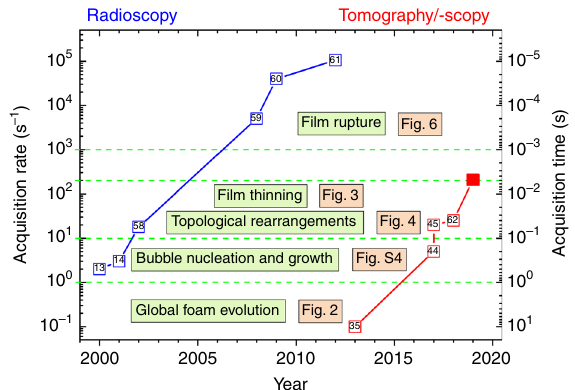
Fig. 1 Image acquisition rates and times used to study metal foams. The highest image acquisition rates in each year achieved for 2D radioscopic (blue, in s − 1 , fps) 13,14,58 – 61 and 3D tomoscopic (red, in s − 1 , tps) 35,44,45,62 analyses of evolving liquid metal foams are given. The horizontal broken lines delimit the image acquisition rate ranges required for the study of the phenomena named in the boxes highlighted in green. Figure numbers refer to fi gures of this paper. The numbers in the small open squares are references. The full red square marks the current